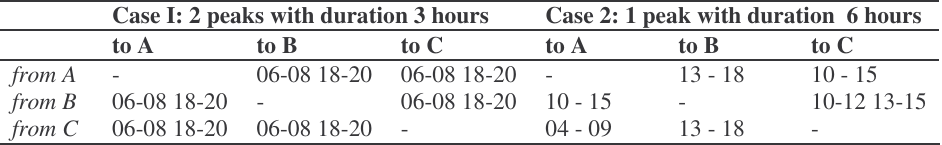
Table 4. Time point of the peak periods of the examples Case I: 2 peaks with duration 3